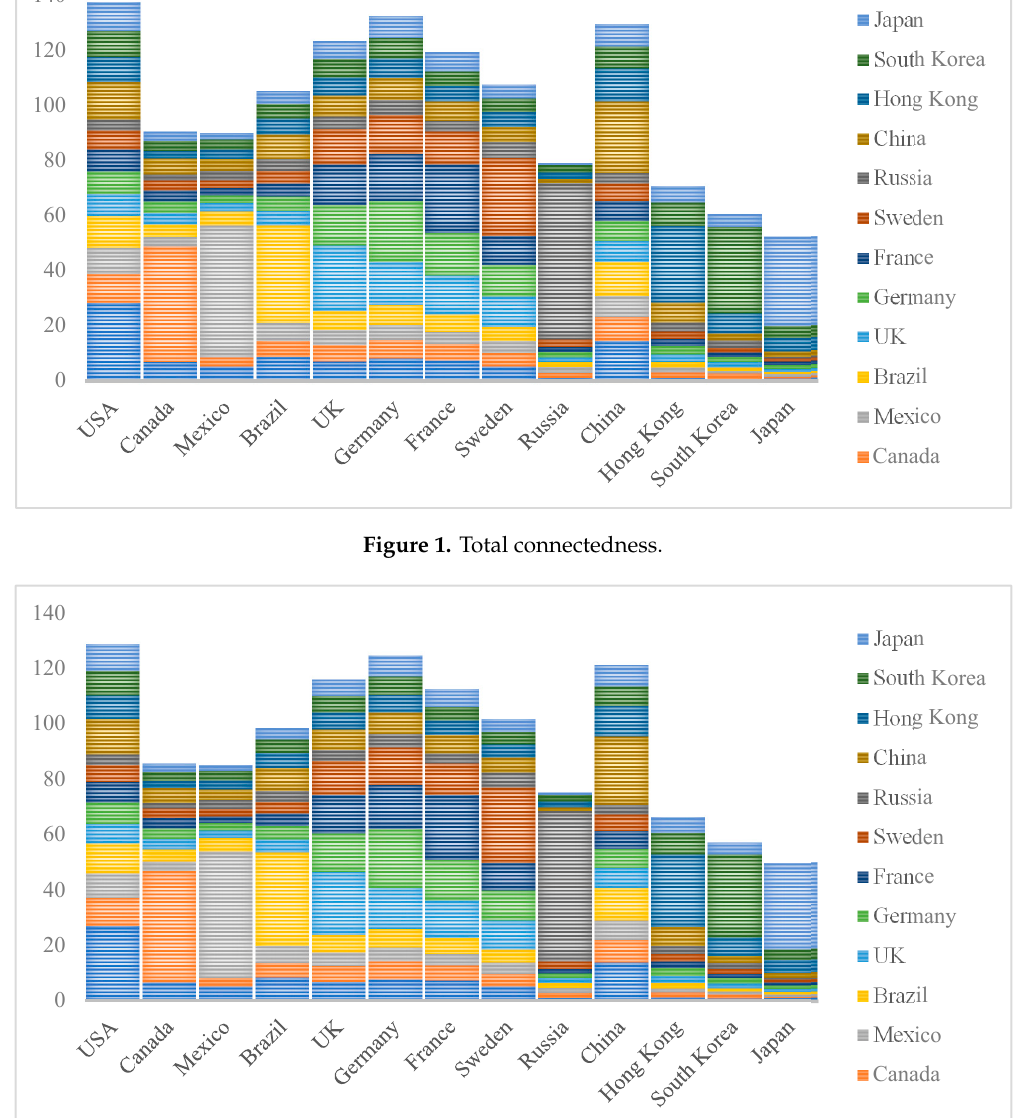
Figure 2. Short-term connectedness.